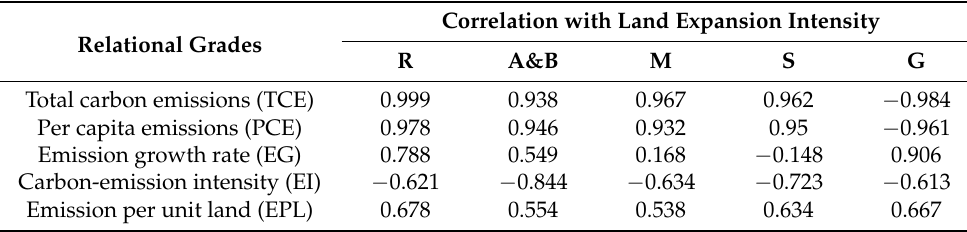
Table 6. Relational grades of the carbon emissions index and urban land use area. Relational